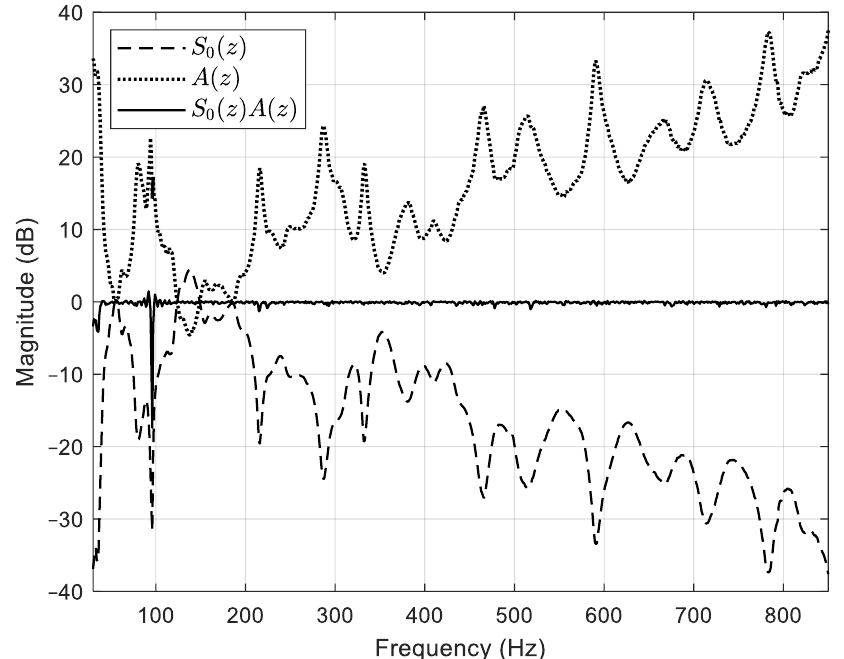
Figure 11. Magnitude responses of S 0 ( z ) (a dashed line), A ( z ) (a dotted line), and S 0 ( z ) A ( z ) (a solid line).